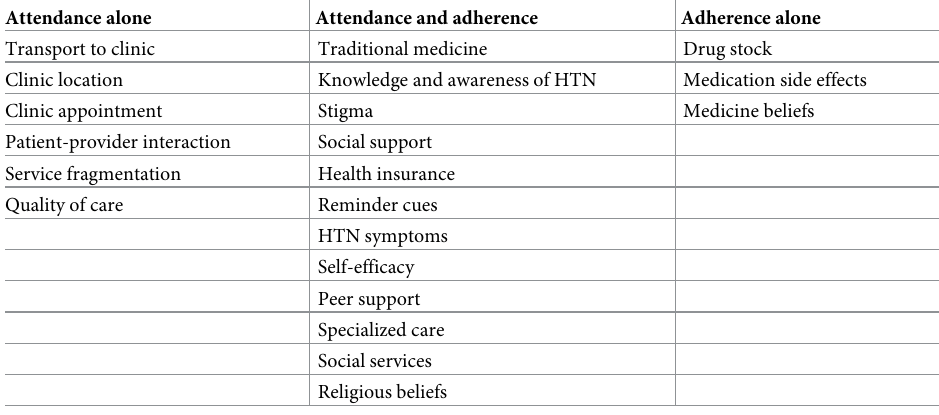
Table 2. Barriers/facilitators affecting clinic attendance and medication